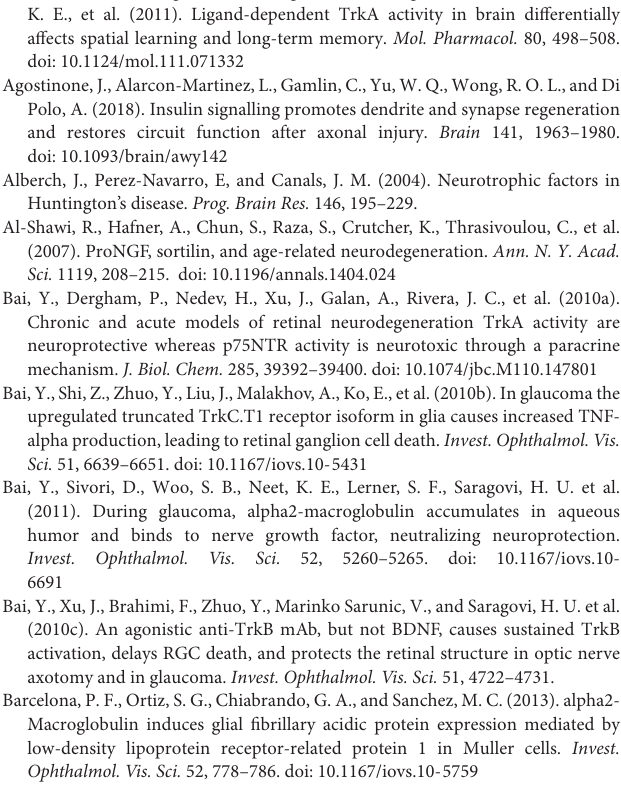
F1000Res . 5:F1000 Faculty Rev-1885. Brahimi, F., Ko, E., Malakhov, A., Burgess, K., and Saragovi, H. U. (2014). Combinatorial assembly of small molecules into bivalent antagonists of TrkC or TrkA receptors. PLoS One 9:e89617. doi: 10.1371/journal.pone.0089617